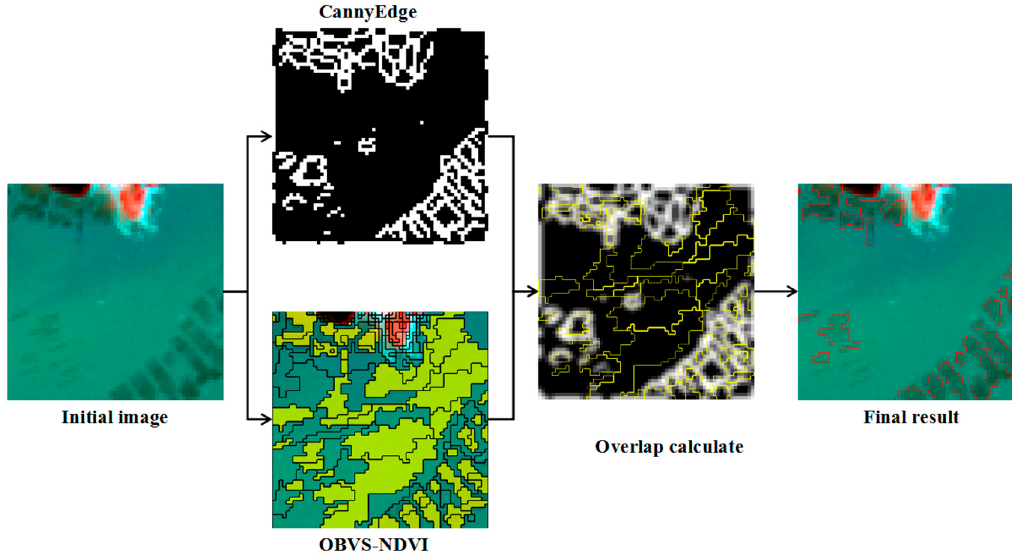
Figure 2. Schematic diagram of overlap calculation.